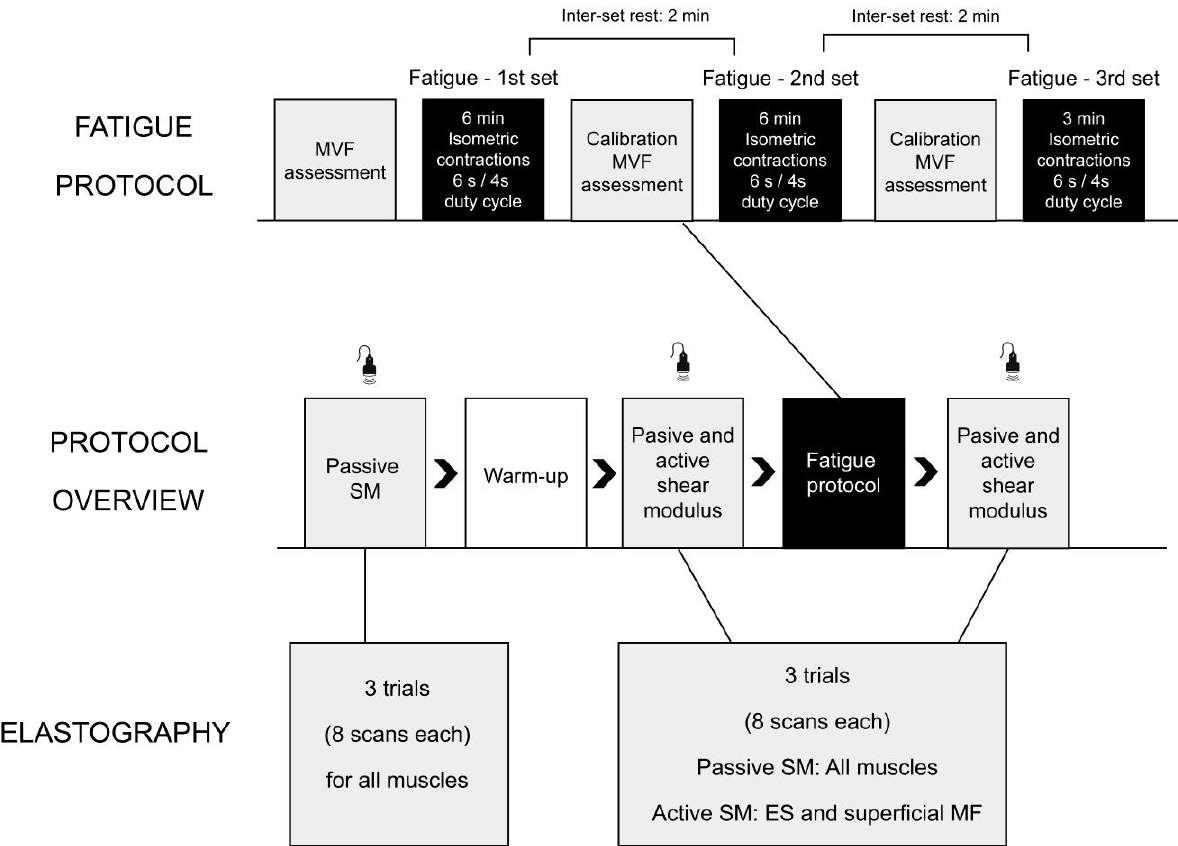
Figure 1. The overview of the